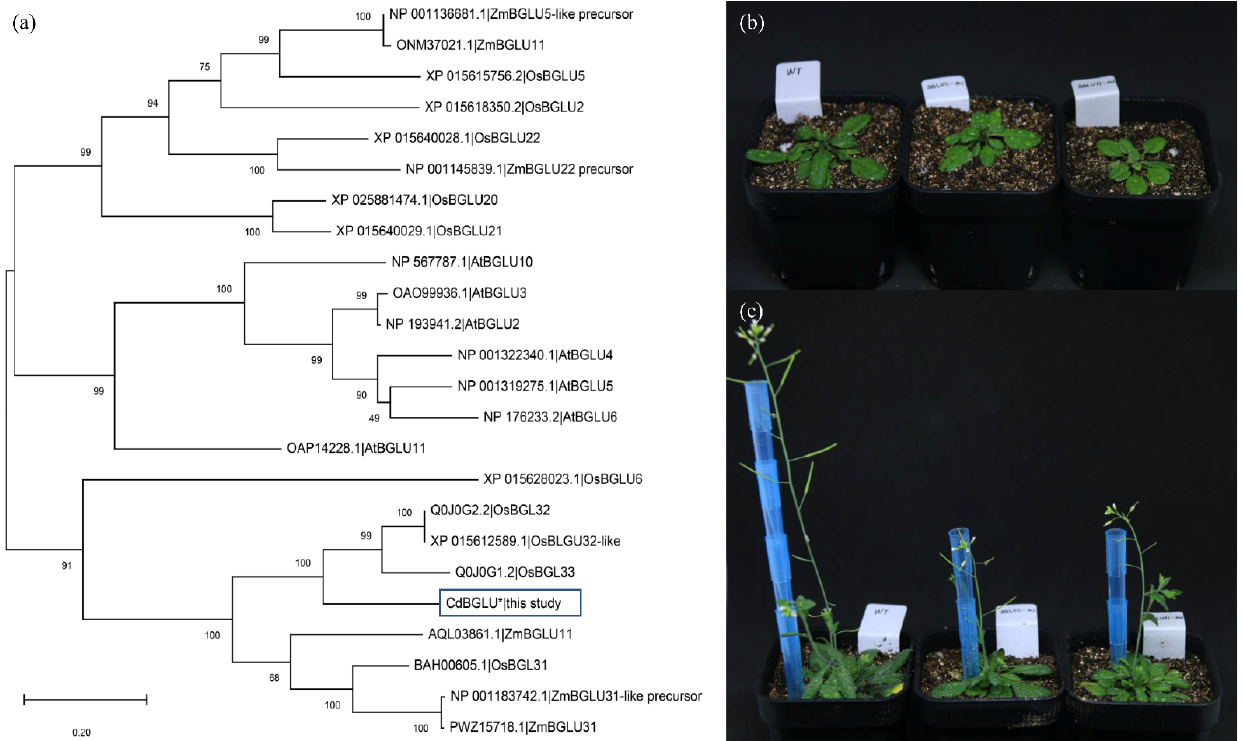
Figure 6. Functional analysis of CdBGLU31. ( a ) Analysis of phylogenetic relationships among BGLU gene. Os, Oryza sativa ; Zm, Zea mays ; At, Arabidopsis thaliana . The black box indicates the bermudagrass gene isolated in this study. ( b , c ) The morphology of Arabidopsis wild type and bglu11 mutants in vegetative growth and heading stage.